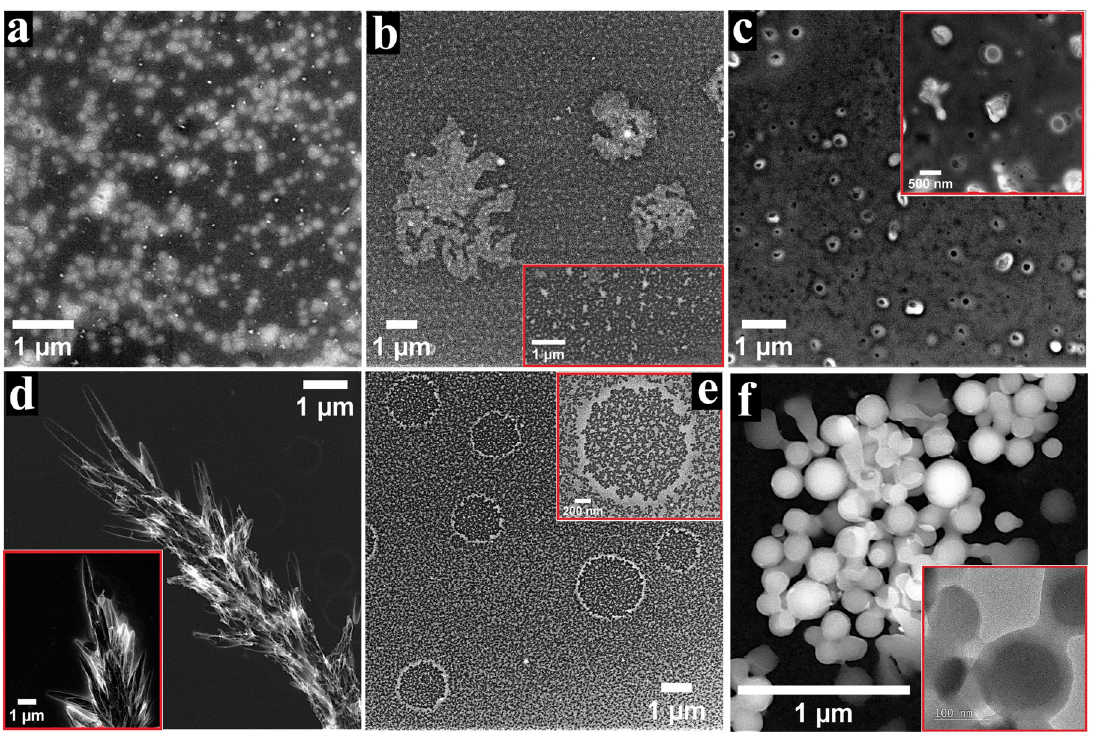
Figure 2. STEM images recorded for CoP drop-casted on TEM grids from solutions obtained using the following solvents: ( a ) DMSO, ( b ) DMF, ( c ) CH3CN, ( d ) PhCN, ( e ) EtOH, and ( f ) THF. The insets are STEM and TEM images that provide additional information about the specimens.